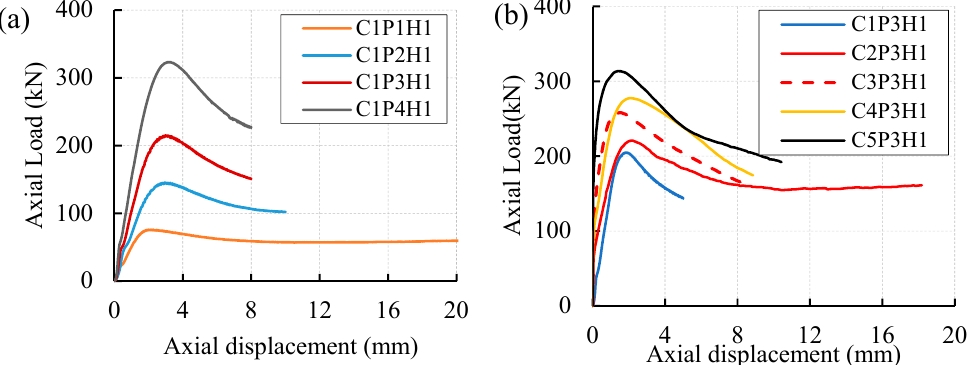
Figure 7. Load-displacement curve of uPVC confined concrete cylinders for: ( a ) different uPVC tube size; ( b ) Different concrete classes.